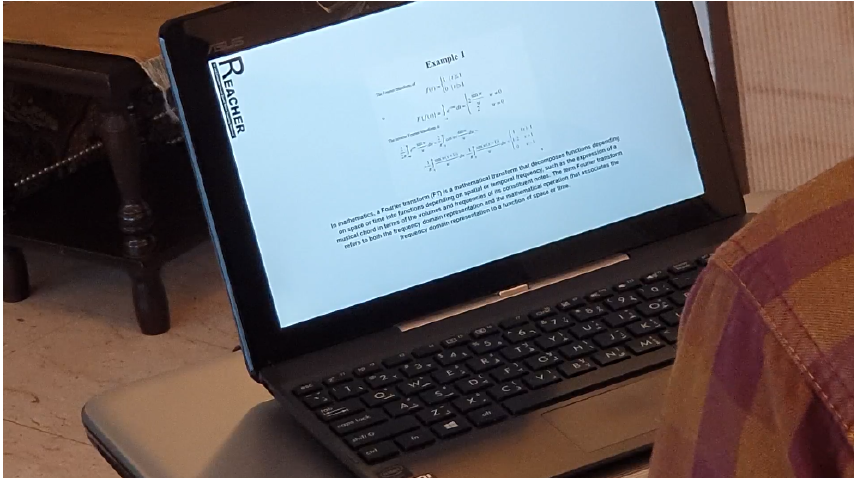
Figure 17. Content retrieval result for an existing